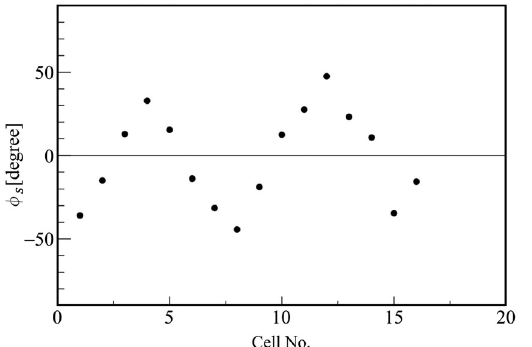
FIG. 3. Optimized phase ( ϕ (gap) number.